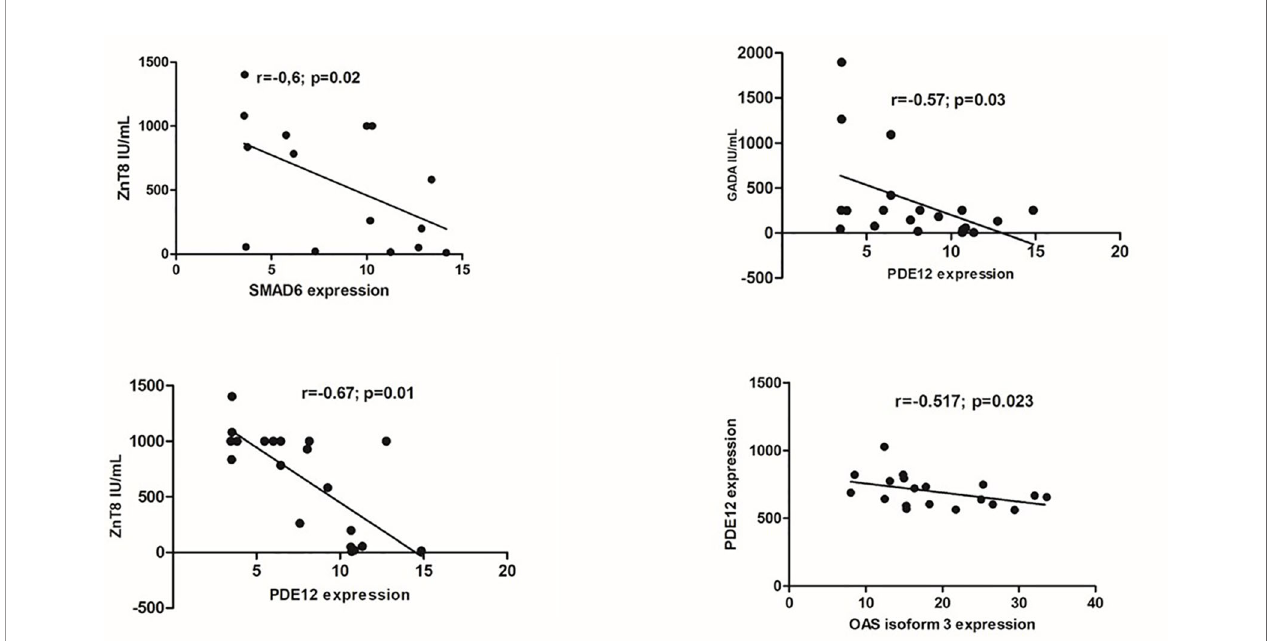
FIGURE 5 | Correlations between gene expression (in peripheral blood mononuclear cells) and serum levels of anti-glutamic acid decarboxylase (GADA) and anti- zinc transporter 8 (ZnT8A) autoantibodies.; SMAD6- Mothers against decapentaplegic homolog 6; PDE12- Phosphodiesterase 12; OAS 3: 2 ’ ,5 ’ -Oligoadenylate synthetase isoform 3.